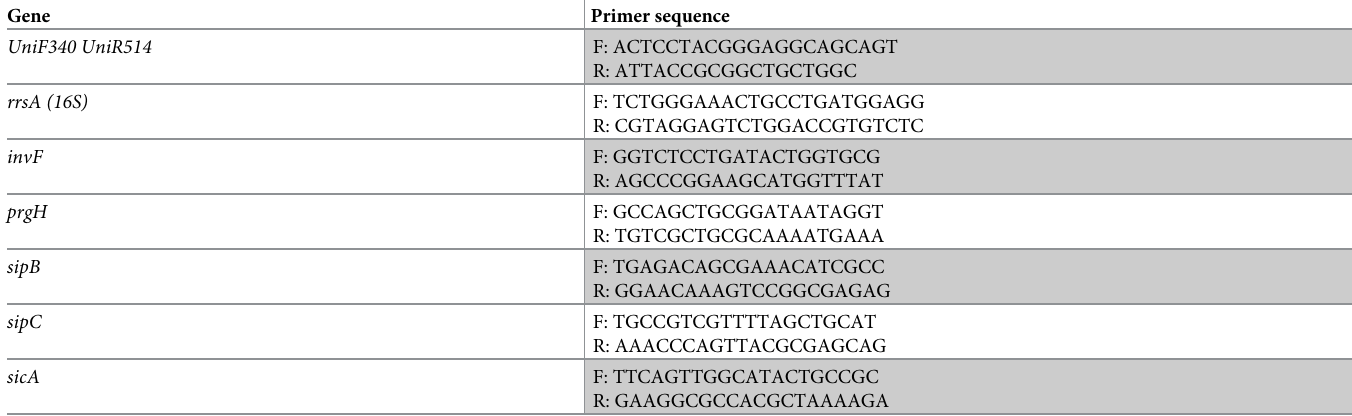
Table 4. Primers used for droplet digital